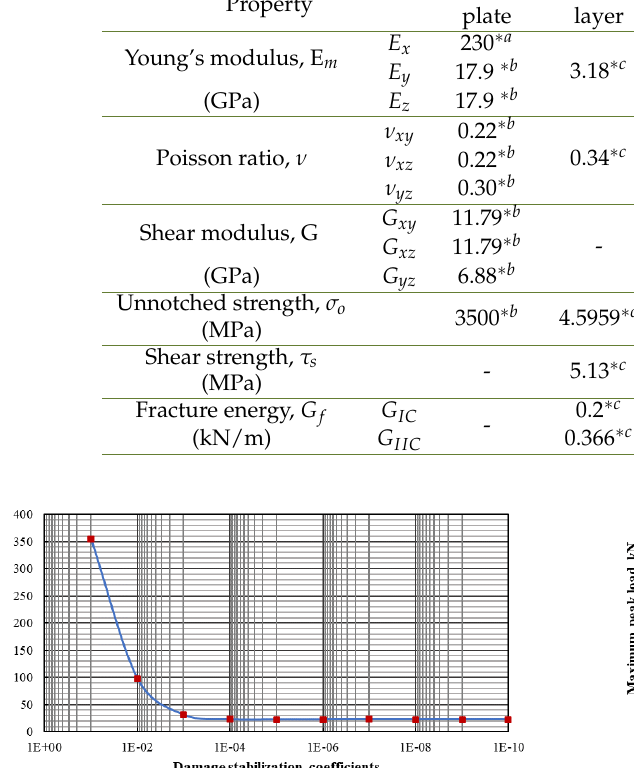
Table 2. Material property used in FEA modelling (after Al-Rousan et al. [21] ∗ a ; Mahmoud [24] ∗ b ; Mohammadi and Wan [18] ∗ c ; Zhang and Liu [25] ∗ d ) Adhesive Concrete